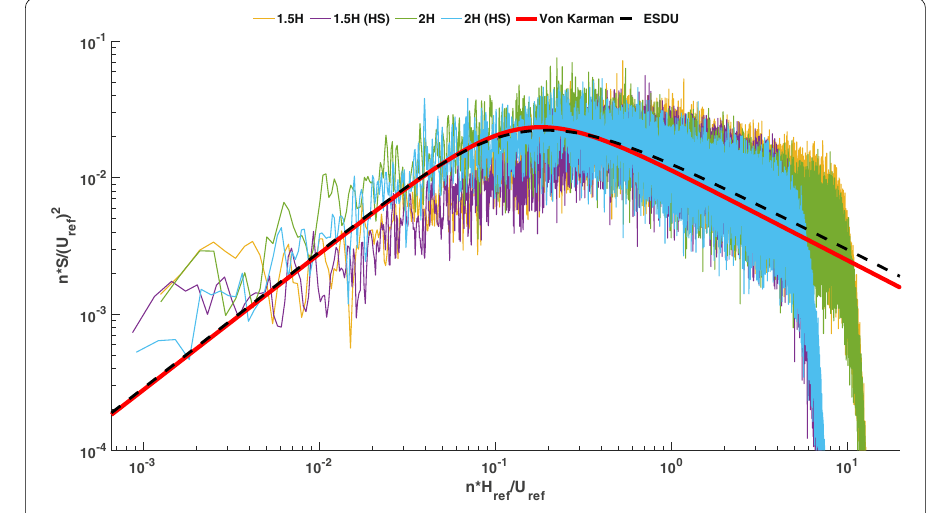
Fig. 9 Comparison of turbulence content by varying velocities